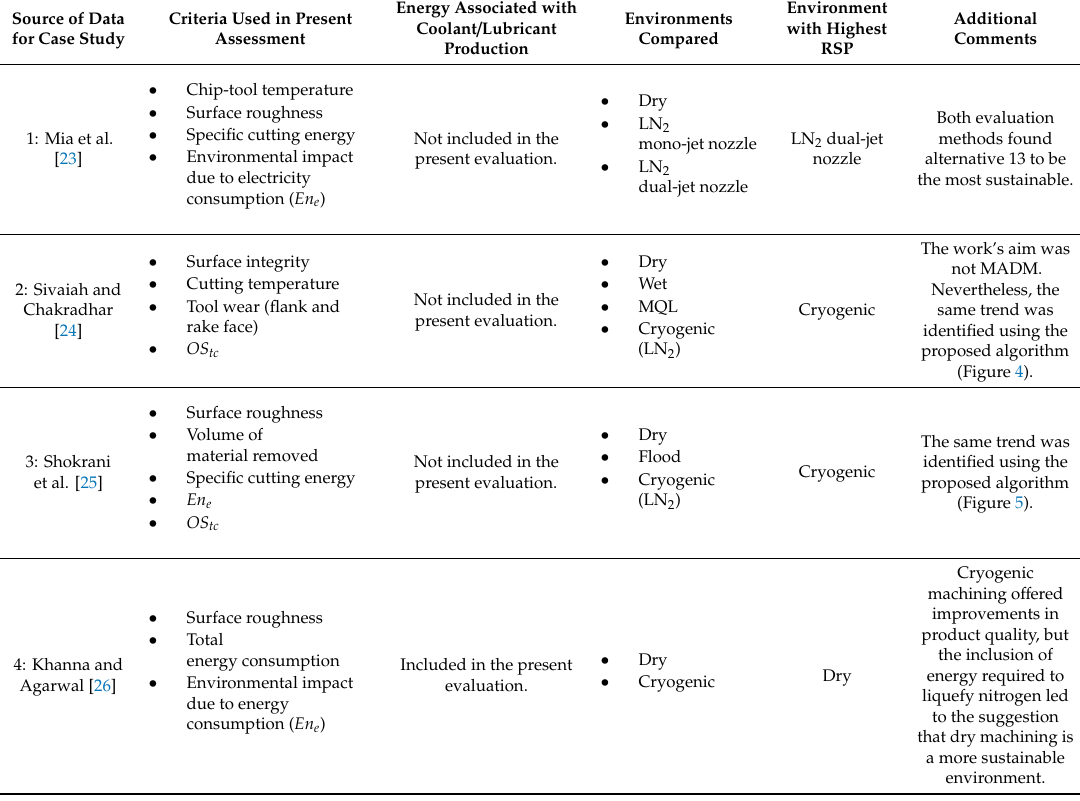
Table 3. Validation of the algorithm using critical cases from the